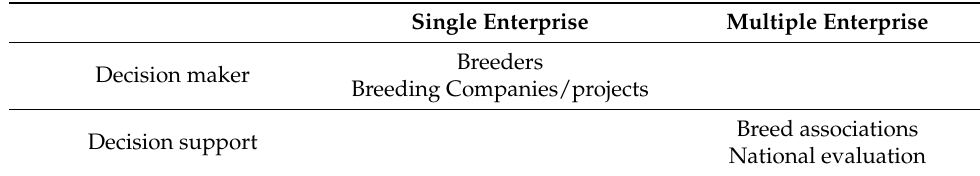
Table 1. Classification of